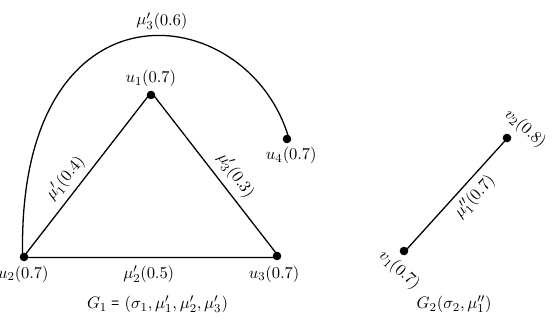
Figure 9: Two Fuzzy Graph Structures G 1 and G 2 Figure 9. Two fuzzy-graph structures G 1 and G 2 .